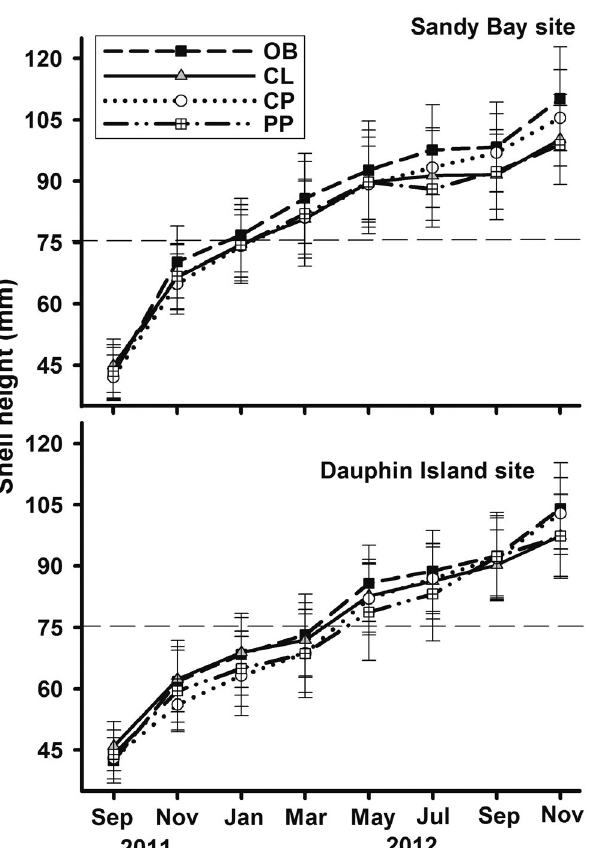
Fig. 6. Mean (±SD) shell heights of Louisiana eastern oysters from the OBOY (OB) and Calcasieu Lake (CL) stocks, and Alabama oysters from the Cedar Point (CP) and Perdido Pass (PP) stocks at the Sandy Bay and Dauphin Island study sites. Dashed lines at 75 mm represent harvest threshold shell height